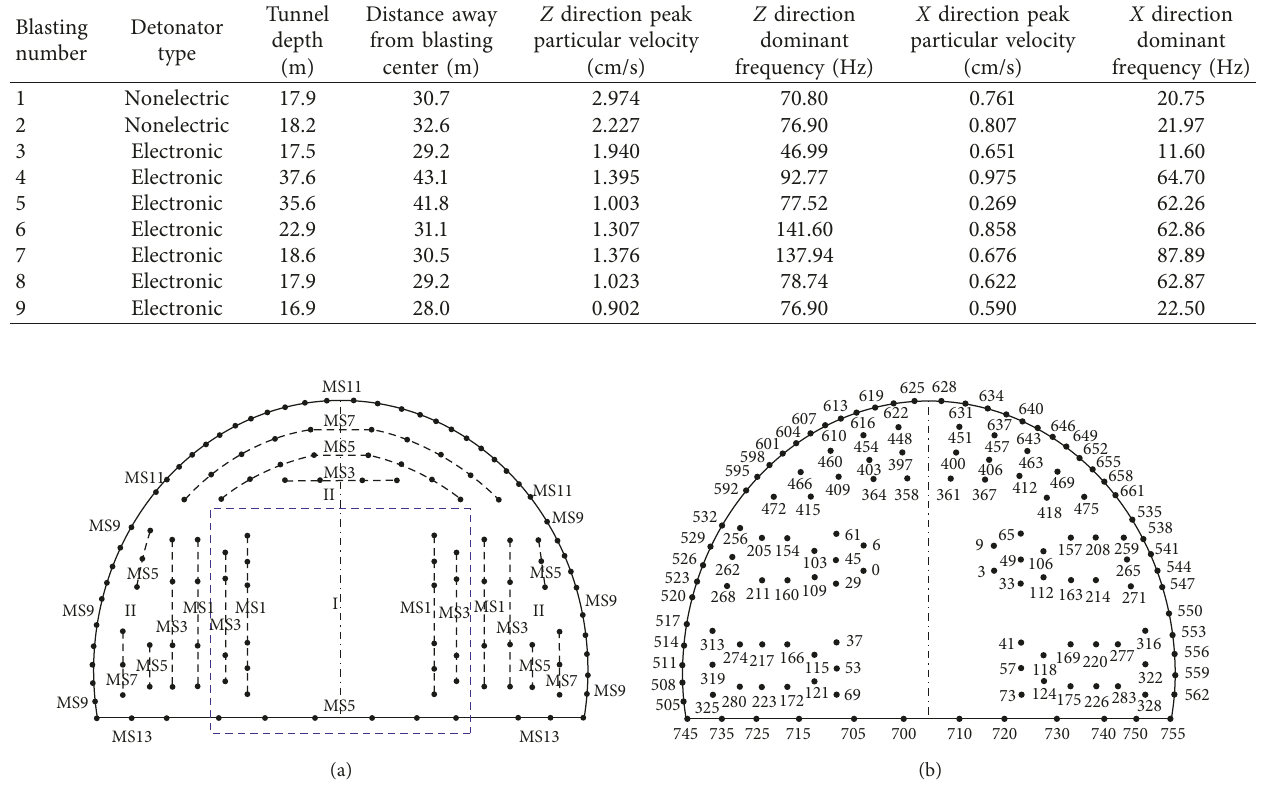
Figure 2: Layout of blast holes and initiation time (unit: ms). (a) Using nonelectric detonator. (b) Using digital electronic detonator.